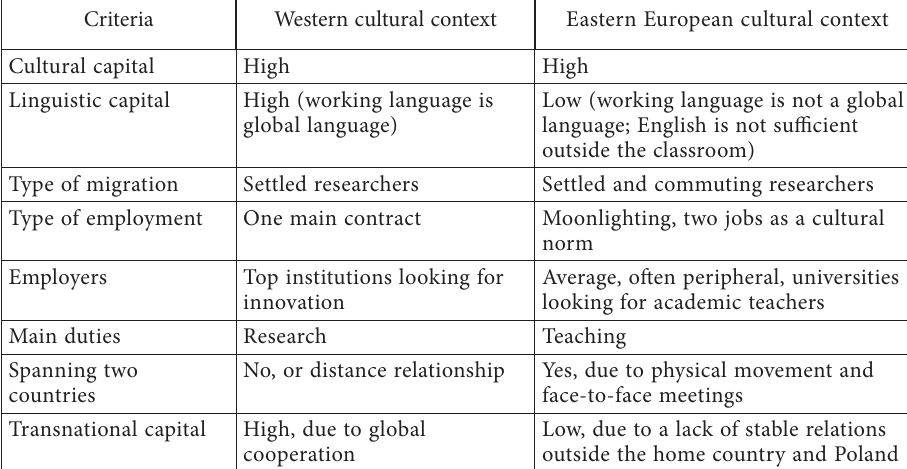
Table 4. Foreign-born academic in the Western and Eastern European context (source: created by authors)